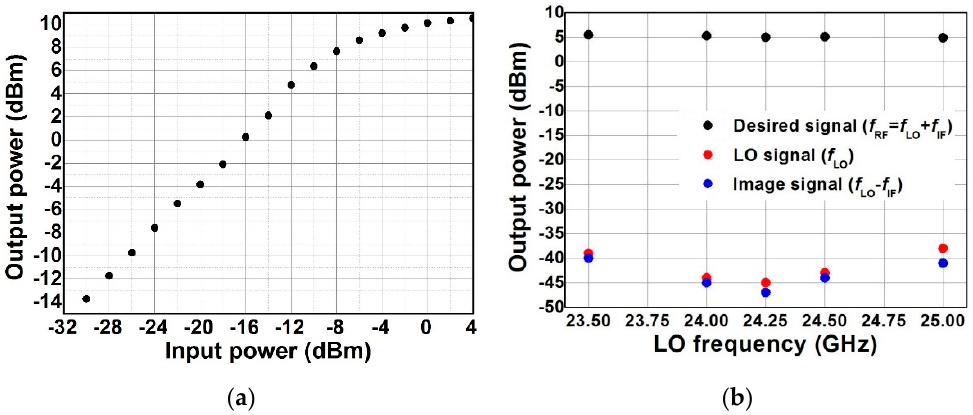
Figure 12. ( a ) Measured output power at RF output frequency of 24 GHz, ( b ) measured output spectrum at 5 dBm of desired RF signal output. (IF frequency used was 10 MHz).